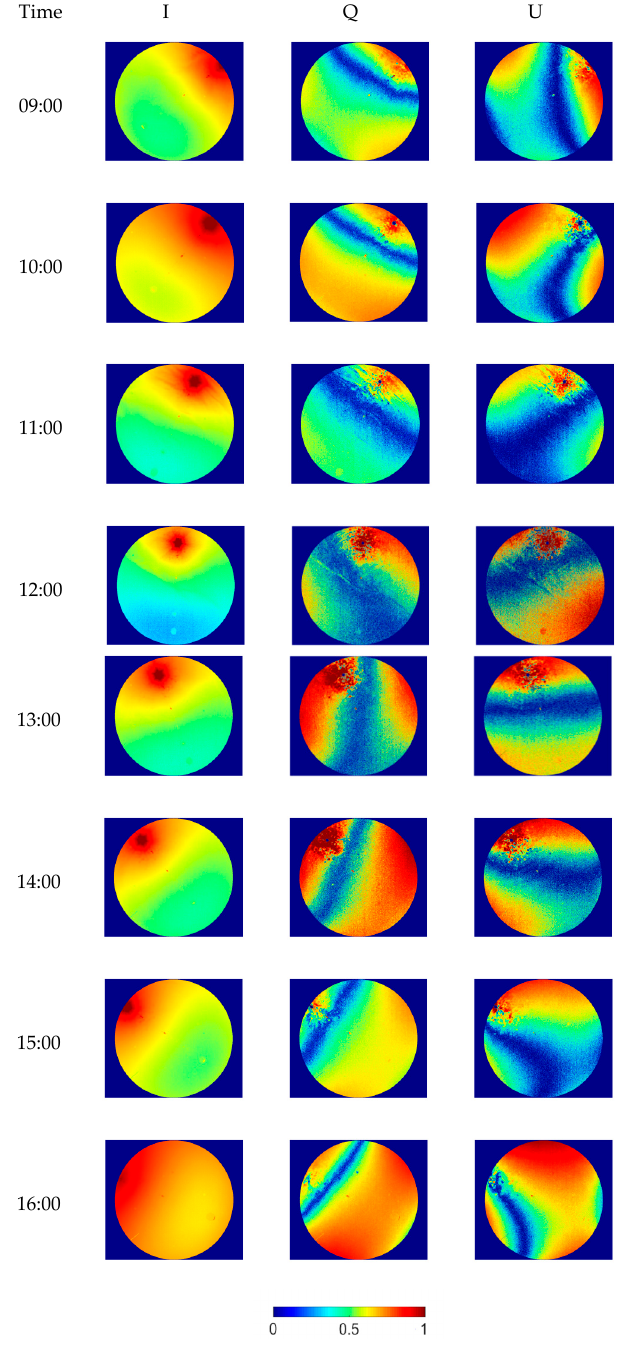
Figure 3. Daily variation in the Stokes component of skylight (March 13, 2019).